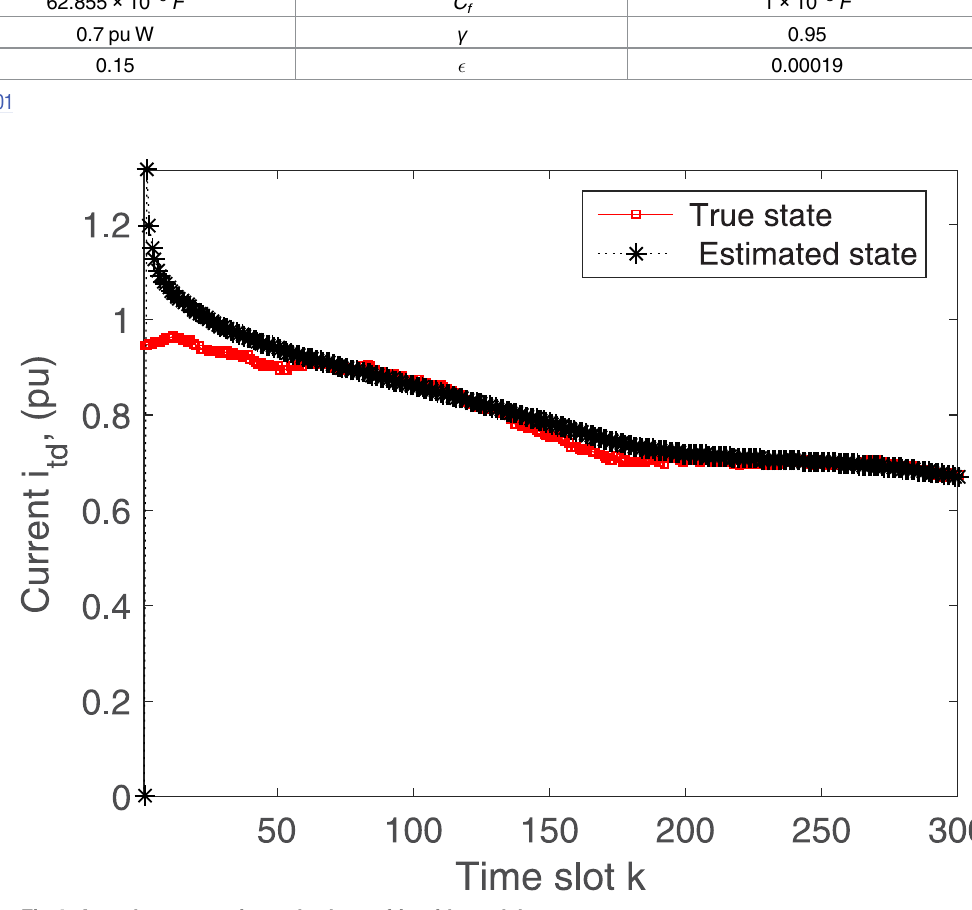
Fig 4. Actual versus estimated values of i td without